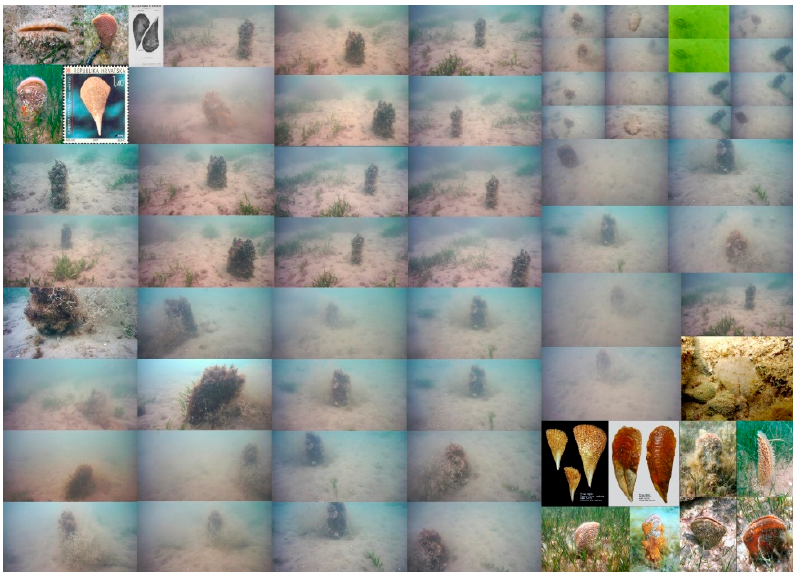
Figure 6. Pictures used for custom CV model training.